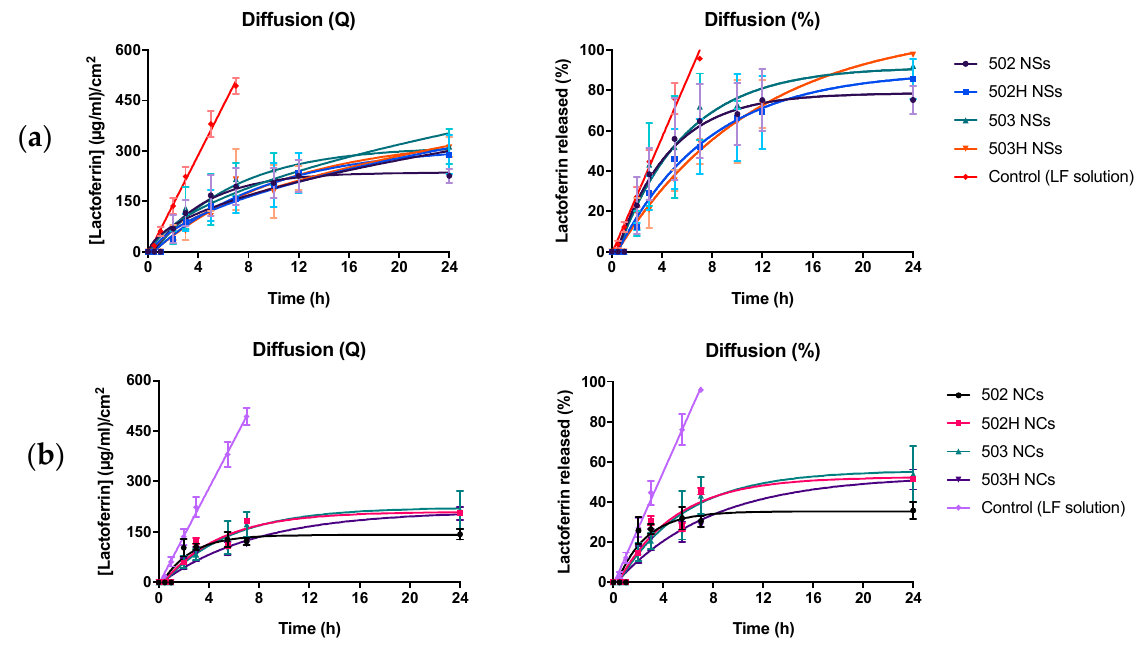
Figure 12. In vitro release study of Lf from PLGA NSs ( a ) and NCs ( b ). The first graph embodies the raw amount of Lf corrected by the available surface released from the PLGA NSs over the 24 h period. The second graph represents the percentage of Lf released from the PLGA NSs over the 24 h period. No statistically significant differences were observed among all the PLGA-based formulations ( p > 0.05).